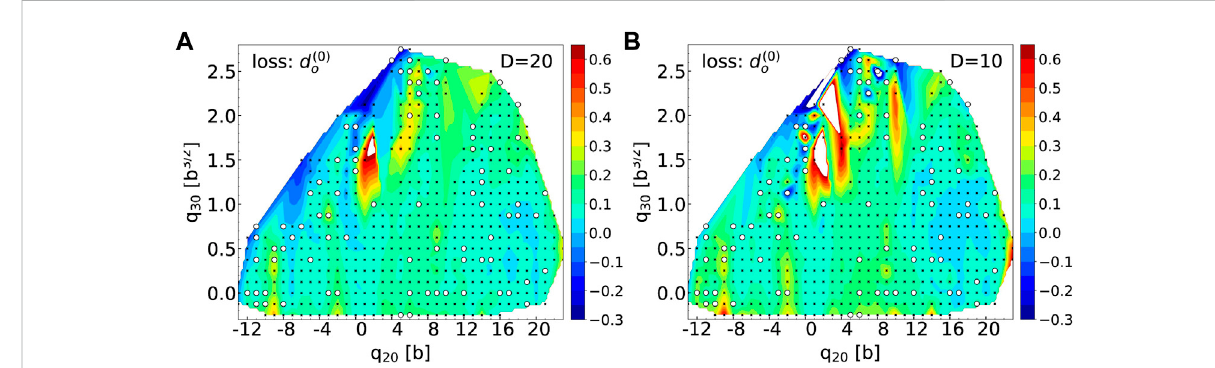
FIGURE 12 (A) : Potential energy surface in the ( q 20 , q 30 ) plane for 98 Zr obtained after replacing the fi rst n n = 87 and n p = 60 highest-occupation canonical wavefunctionsbytheirvaluesreconstructedbytheAEforalatentspaceofdimension D =20.Theblackdotsshowthelocationofthetraining points only,thewhitecirclesthelocationofthevalidationpoints. (B) :same fi gureforalatentspaceofdimension D =10.Forboth fi gures,energiesaregiven in MeV.